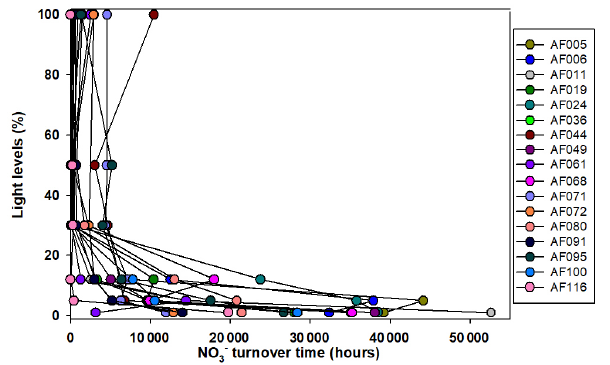
Figure 7. Turnover times for the NH + toplankton are the only consumers, in the sampling